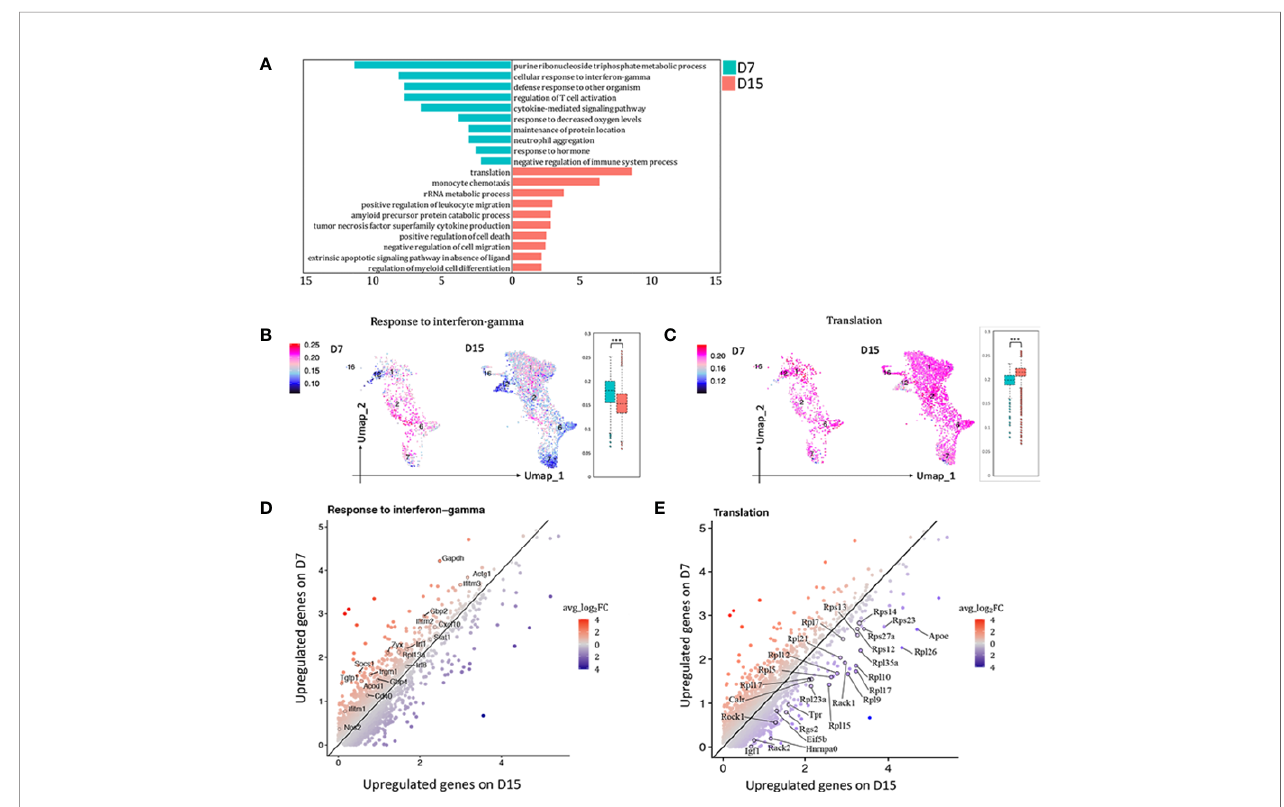
FIGURE 5 | Blunted response to interferon gamma contributed to acute rejection chronicization. (A) Differences in hallmark pathways of macrophages from different rejection types as determined by Metascape. Feature plot and bar plot showing gene-set activity scores of GO pathway (B) response to interferon gamma, (C) translation. Each point depicts a single cell, colored according to normalized gene-set activity scores. Average scale is shown on the left. Scatter plot depicting DEGs enriched inpathway (D) response to interferon gamma and (E) translation. Each dot represents a gene, colored according to the avg_log 2 FC fromwhite to blue or red.Only DEGs with avg_log 2 FC>0.59 were circled and labeled.D7, day 7; D15, day 15; avg_log 2 FC, average log 2 fold change; adj_p value, adjusted p value. ***p <